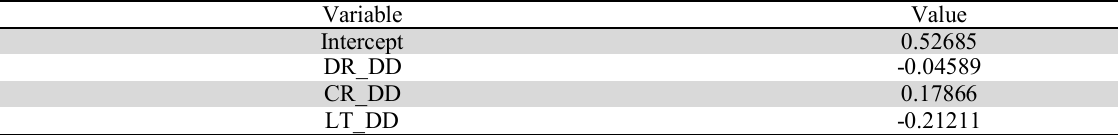
Model coefficients